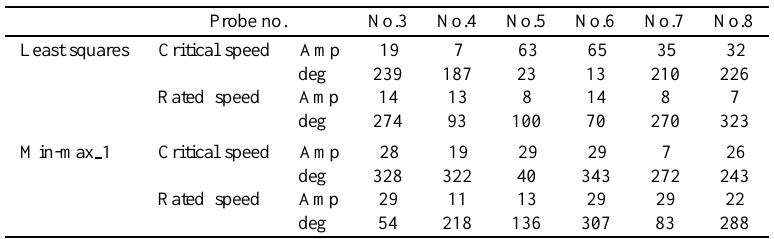
Table 4 Vibration with least squares balancing and min-max 1 balancing for the nuclear turbine